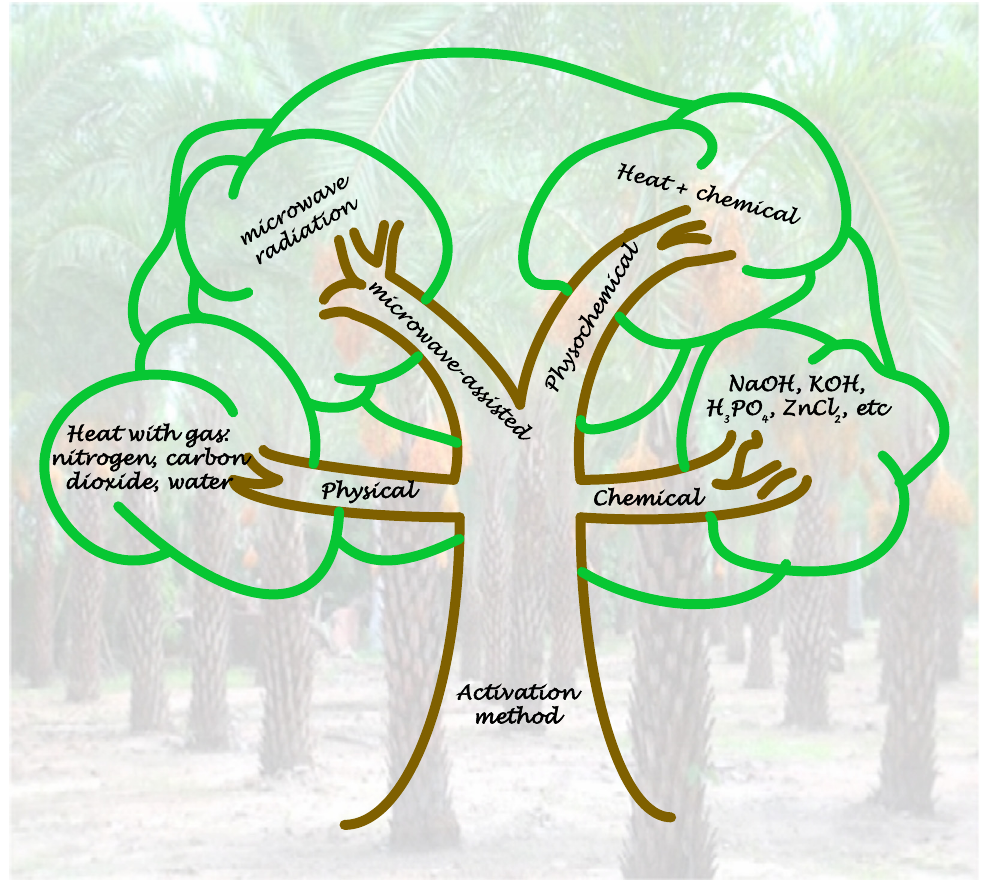
Figure 2: Activation methods of AC from Arecaceae.